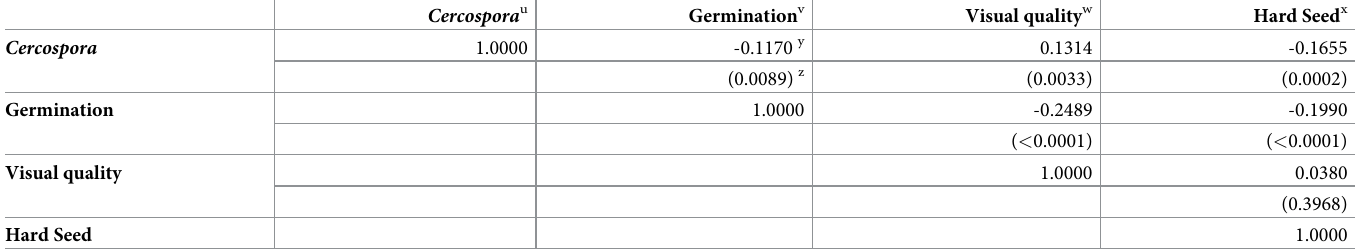
Table 6. Pearson correlation coefficients between percentage of seed infection with Cercospora species, germination, and seed visual quality in replicated field tests in Stoneville, Mississippi, in 2010, 2011, and